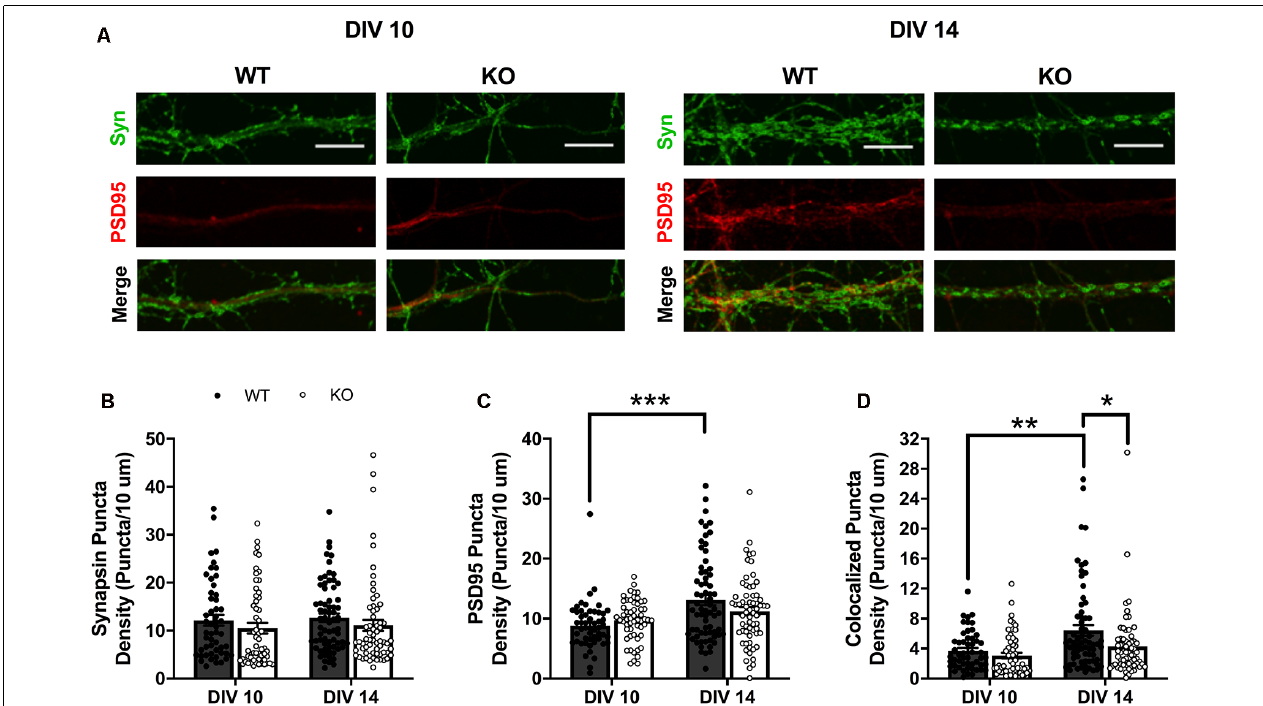
FIGURE 1 | Expression of presynaptic (synapsin I; green) and postsynaptic (PSD95; red) markers in wildtype (WT) and Fmr1 knockout (KO) medium spiny neurons (MSNs) at day in vitro (DIV) 10 and 14 ( A ; scale bars are 10 µ m). Synapsin I expression did not vary between genotypes or across the two time-points ( B ; two-way analysis of variance, ANOVA). WT cells have significantly increased density of PSD95 at DIV 14 compared to DIV 10, but KO cells show no change in expression level between the two time points ( C ; two-way ANOVA). Only WT cells increase the density of colocalized pre- and postsynaptic markers from DIV 10 to 14, with KO cells showing a significant deficit at DIV 14 compared to WT counterparts ( D ; two-way ANOVA). Significant Bonferroni comparisons are indicated (* p < 0.05, ** p < 0.01, *** p < 0.001); data shown are mean ± SEM.